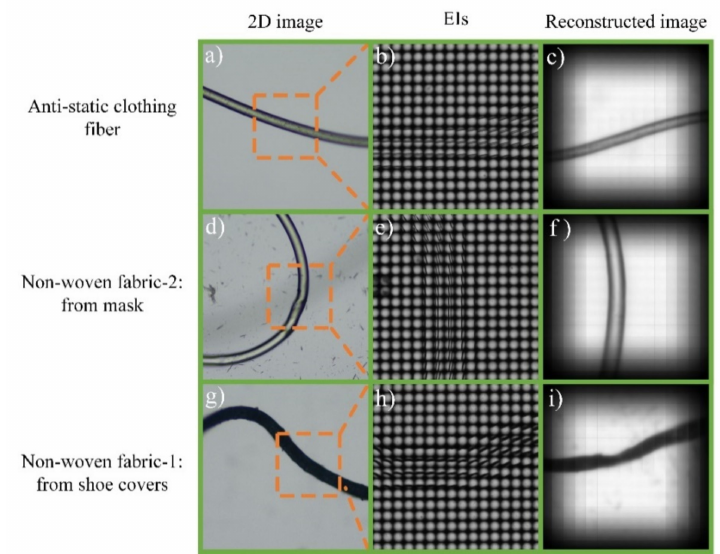
Figure 7. 2D images ( a , d , g ), elemental images (EIs) ( b , e , h ) and reconstructed images ( c , f , i ) of three different targets on the first sample in the experimental studies.